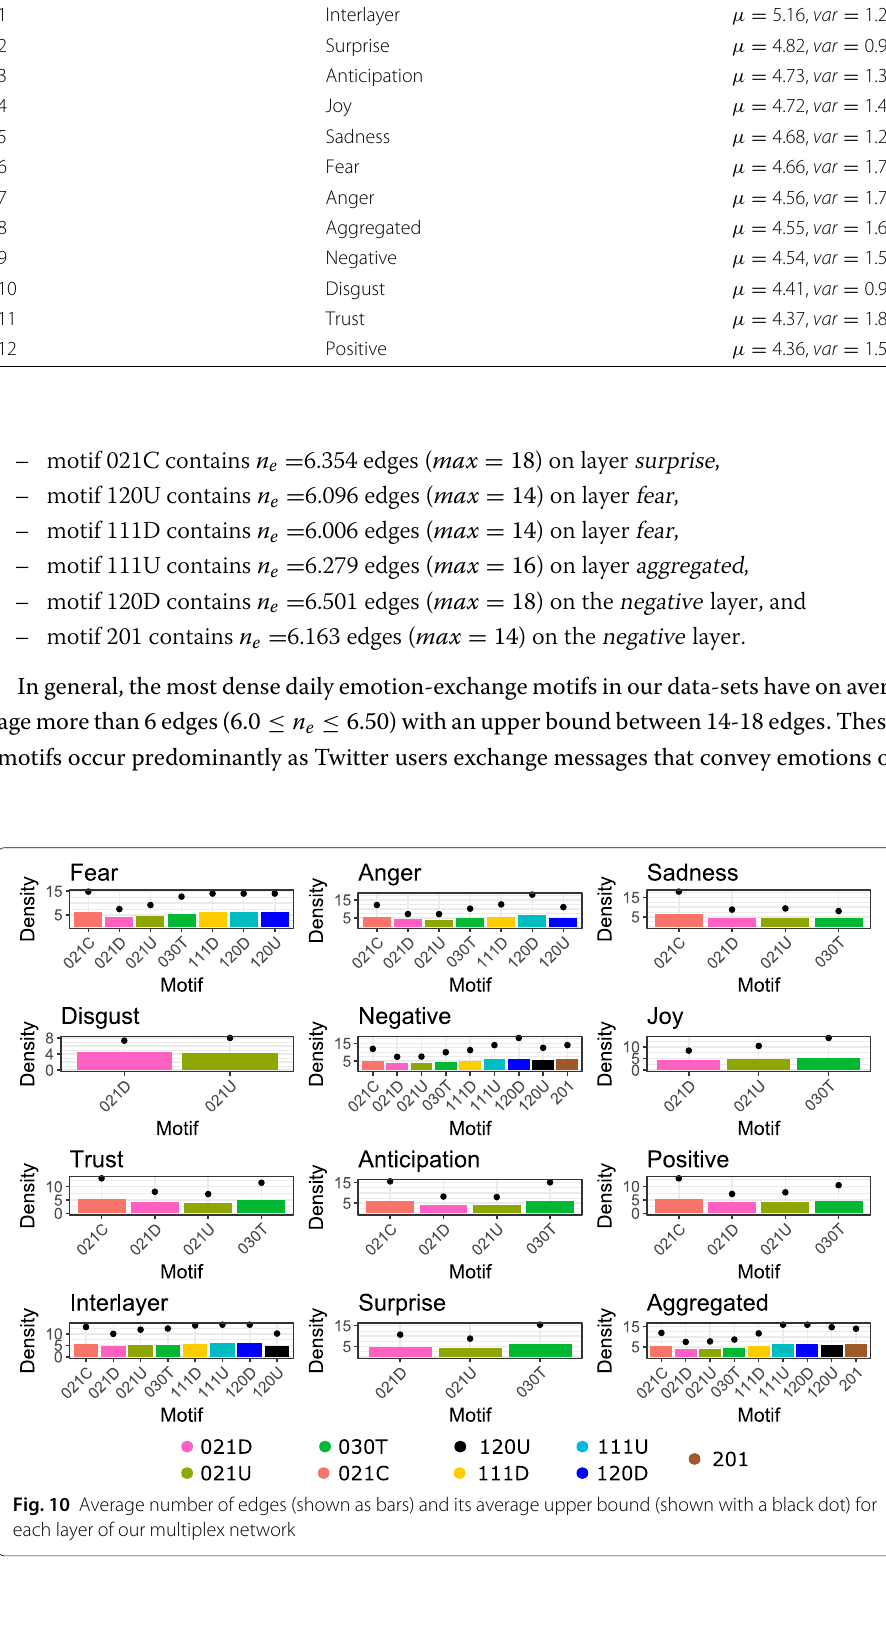
Table 4 Average number of edges ( μ ) and its variance on each layer of our multiplex network Layer Number of edges 1 Interlayer μ = 5.16, var = 1.23 2 Surprise μ = 4.82, var = 0.97 3 Anticipation μ = 4.73, var = 1.35 Joy μ = 4.72, var = 1.44